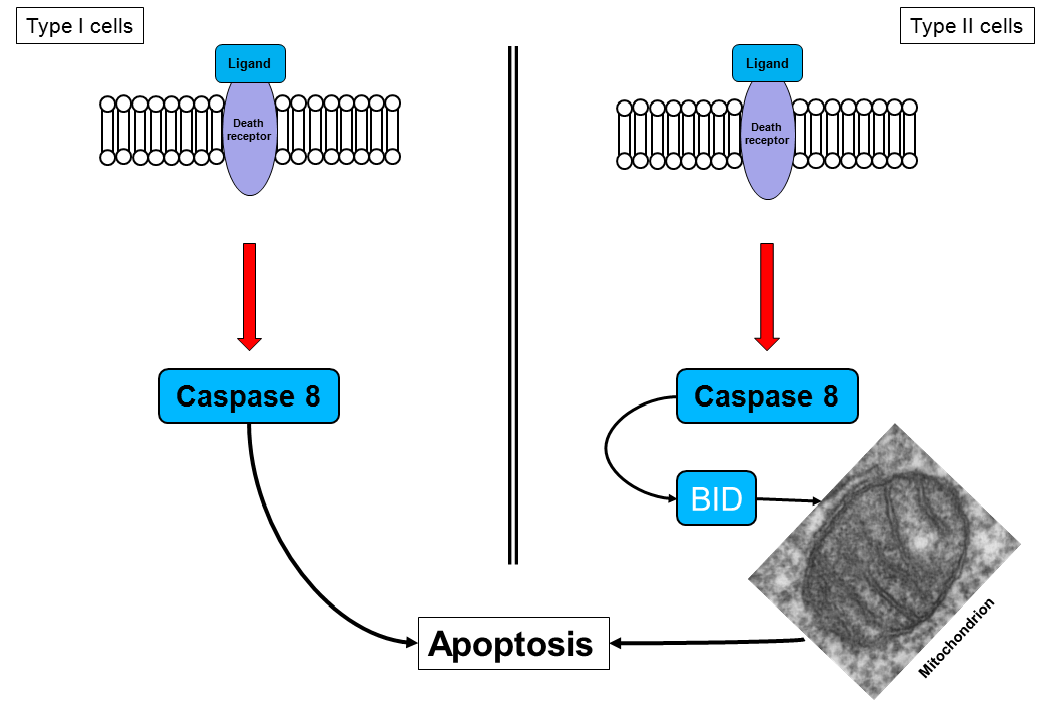
Figure 3. Apoptosis mediated by death receptors in type I and type II cells. In type I